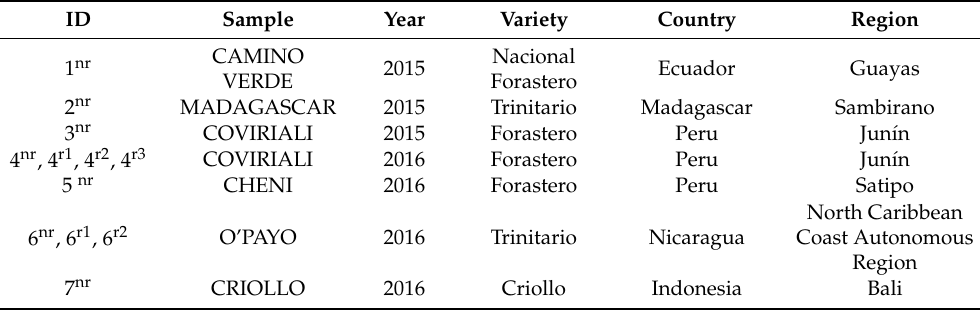
Table 1. List of samples. nr not roasted; r1 95 ◦ C; r2 110 ◦ C; r3 125 ◦